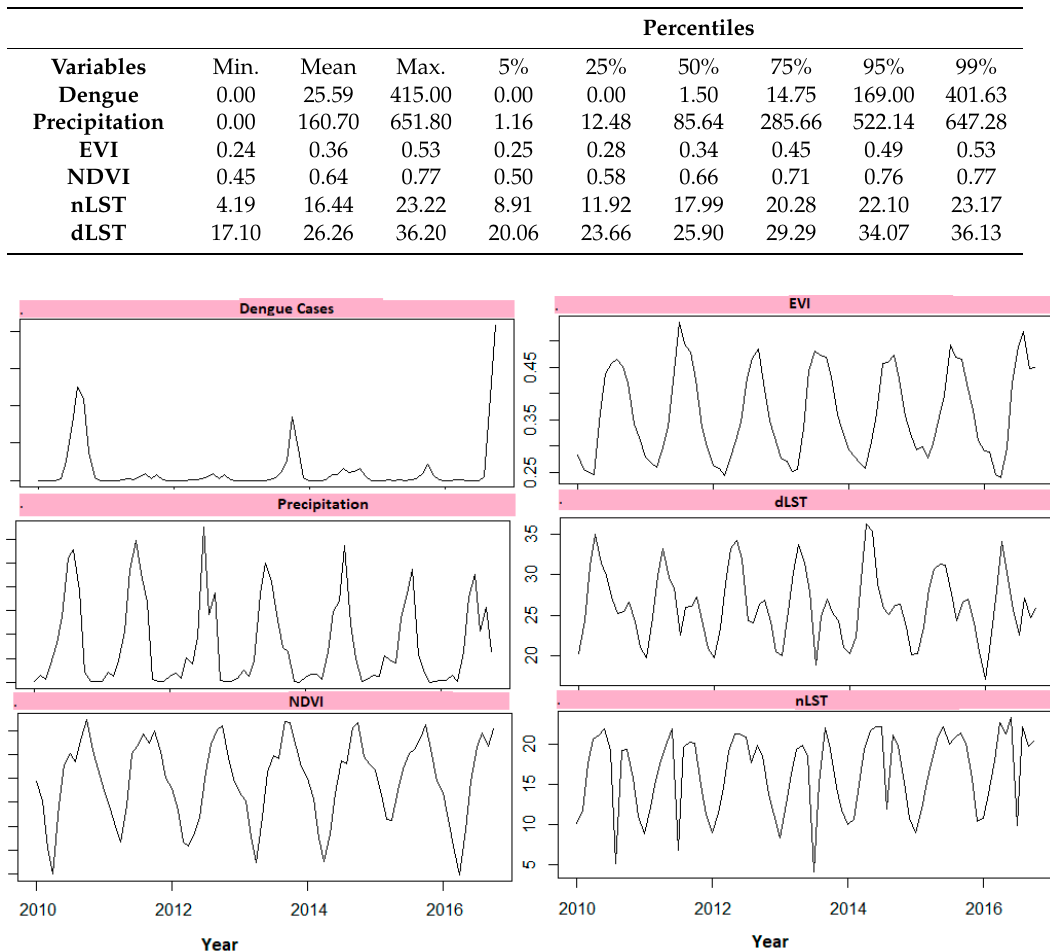
Table 2. Descriptive statistics for monthly dengue cases, and remotely sensed environment variables.